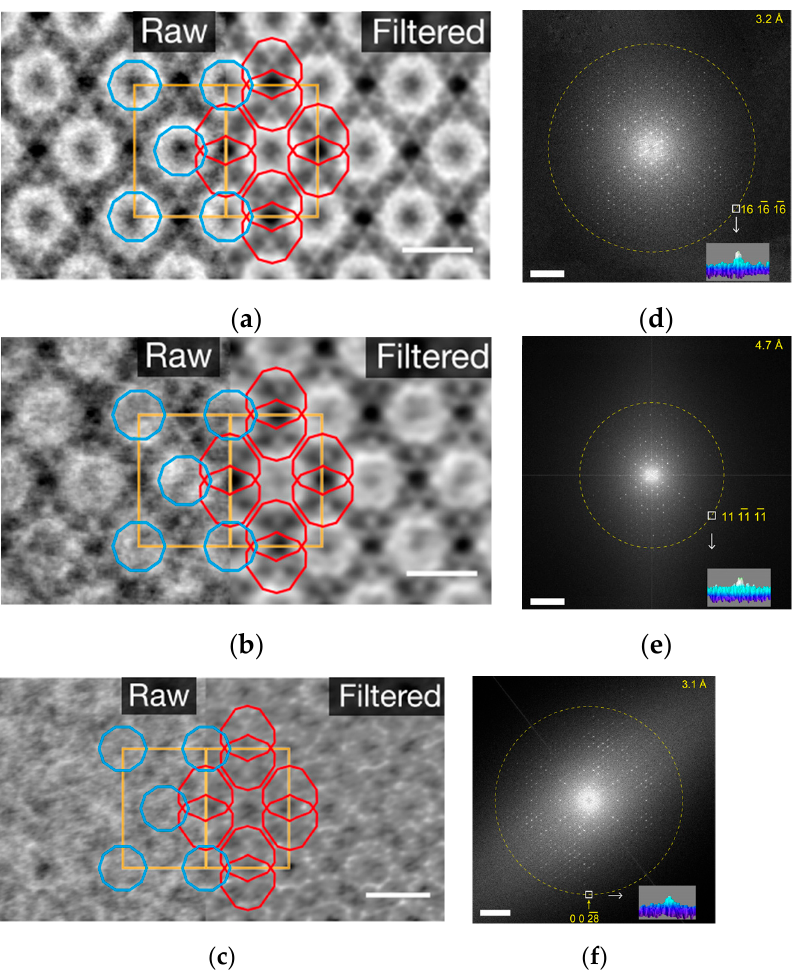
Figure 19. ( a – c ) A series of iDPC-STEM images with increased loading (TiO 2 ); ( d – f ) Increased loading (TiO 2 ) corresponding FFT. Red and blue outlines are overlaid on the images to highlight the positions of TiO 2 units in separate types of mesopores. Scale bars: 5 nm. Reprinted/adapted with permission from Ref. [117]. Copyright 2020, Springer Nature.